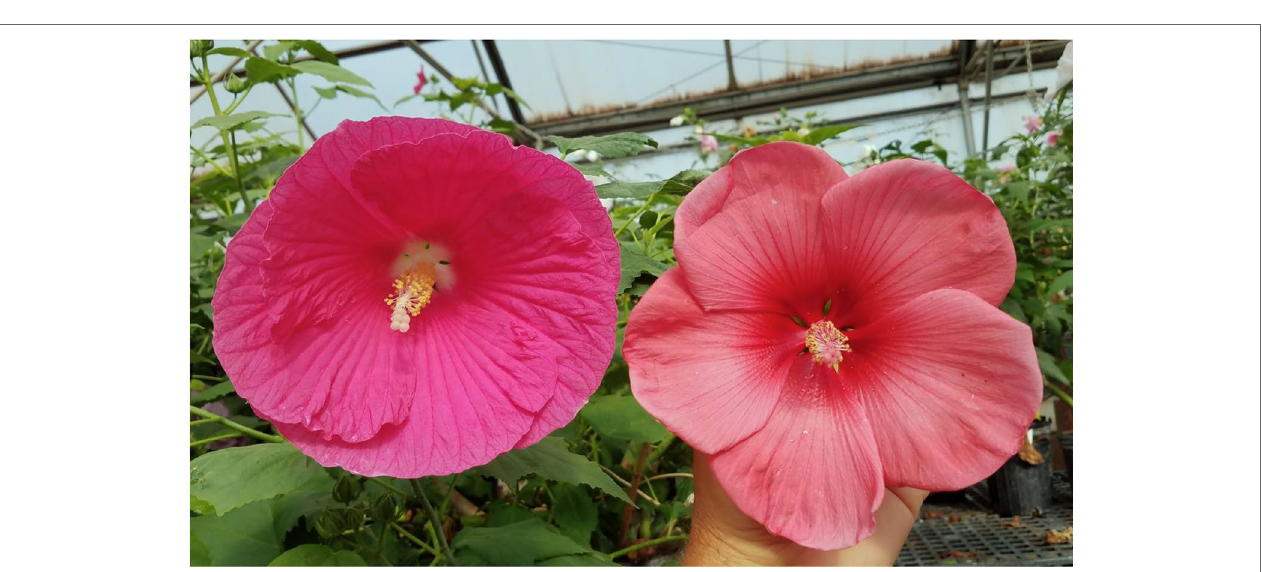
FIGURe 15 | H. x moscheutos hybrid “180266-M1” (right) with a novel, coral or salmon flower color compared with a pink color flower of the hybrid “TAMUS-4336” (left). Photo credits: Dariusz P. Malinowski.